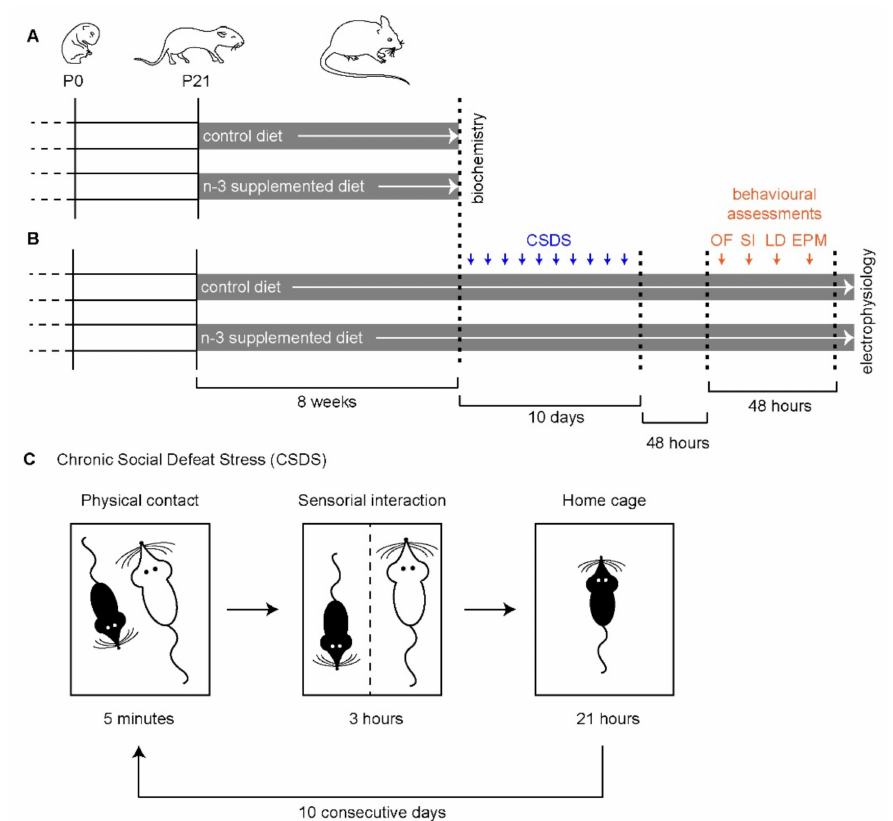
Figure 1. Experimental protocol used in the present study. ( A ) Control and n-3-supplemented diets were given for 8 weeks to C57Bl6/j mice, starting at weaning (P21), before performing biochemical analyses (striatal fatty acid content). ( B ) Following 8 weeks of diet, chronic social defeat stress (CSDS) was performed every day for a total of 10 consecutive days, which was followed by 48 h of behavioral testing, including the open field (OF), the social interaction (SI) test, the light–dark (LD) test, and the elevated plus maze (EPM) test. Two tests were performed per day, in the light phase. Following 48 h of rest, mice were tested for endocannabinoid-dependent plasticity (electrophysiology). ( C ) Detail of the CSDS procedure. Defeated mice are represented in black, while the Swiss CD1 aggressor is represented in white. Drawings are not to